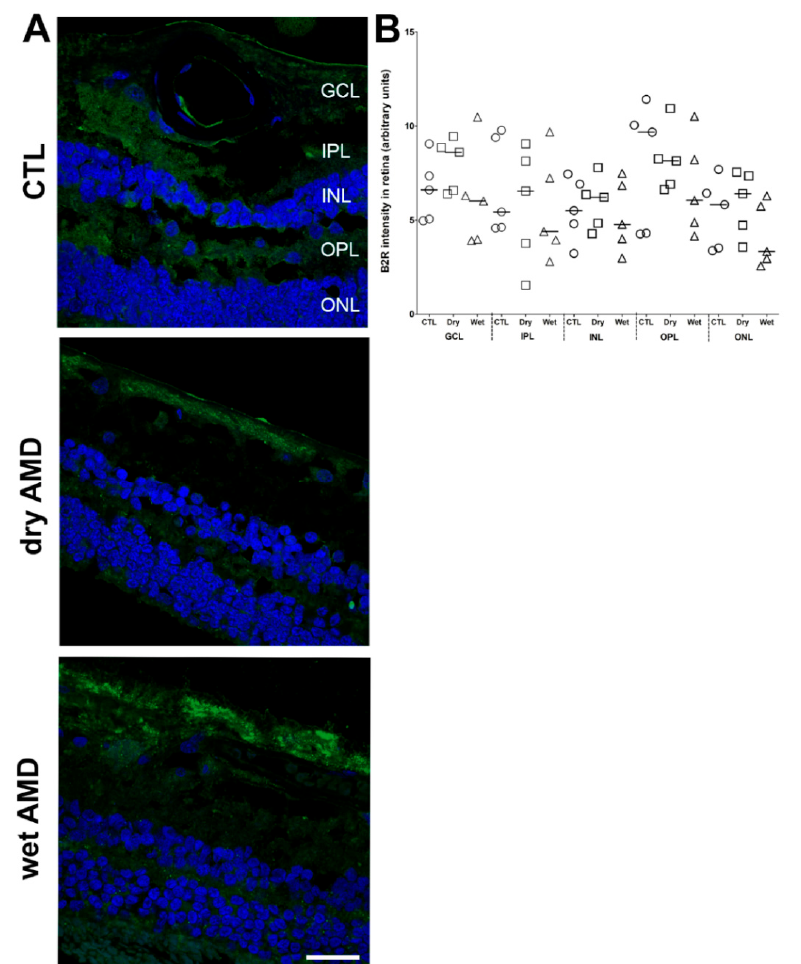
Figure 8. B2R immunoreactivity in human retinae. ( A ) Microphotographs of immunolocalization of B2R in the human control (CTL), dry and wet AMD retinae. All three groups express the same protein levels of B2R, particularly in the GCL and ONL. Sections are counterstained for 4 ′ ,6-diamidino-2-phenylindole (DAPI; blue), which labels cell nuclei. Images were obtained at 40×. Scale bar: 20 μ m. ( B ) Semi-quantification of B2R fluorescence intensity on all the surface area of each retina from five dry AMD, five wet AMD and five control retinae. Data represent mean intensity ± SEM after subtraction of the background intensity. CTL: control (O), Dry: dry AMD ( □ ) , Wet: wet AMD ( △) , GCL: ganglion cell layer, IPL: inner plexiform layer, INL: inner nuclear layer, OPL: outer plexiform layer, ONL: outer nuclear layer.